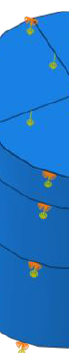
Figure 5. The 3-D FE model after completion of boundary conditions (cross-section view).